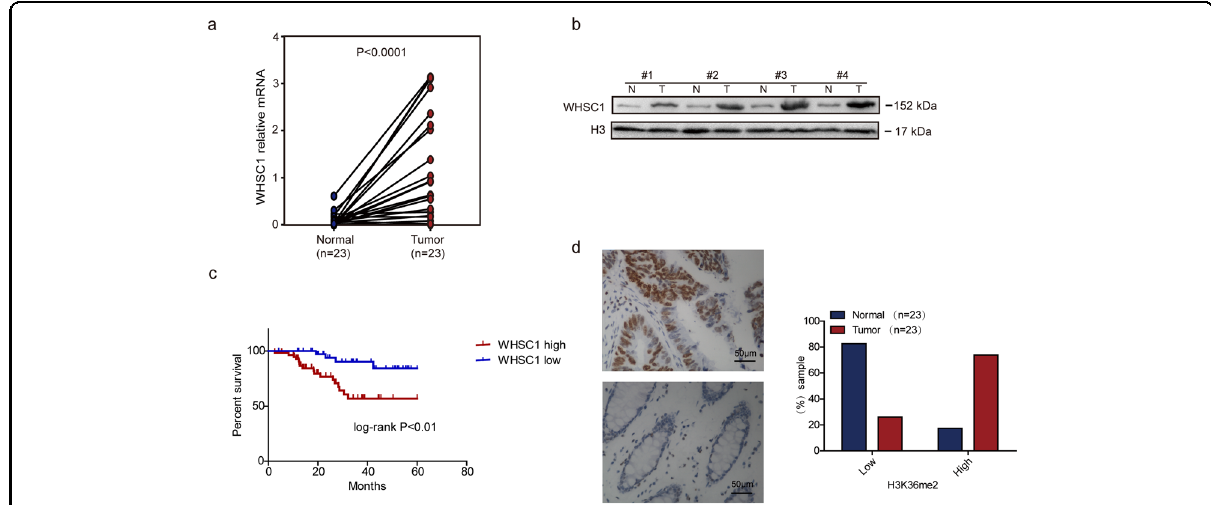
Fig. 1 Elevated WHSC1 expression in human CRC. a WHSC1 mRNA levels in 23 matched tumor and paracarcinoma tissues (paired t- test, P < 0.001). b Immunoblotting analysis of WHSC1 expression in four matched CRC tissues (T) and adjacent noncancerous tissues (N). c Kaplan – Meier plot of overall survival of CRC patients based on WHSC1 levels. A log-rank test was used for statistical analysis. d Expression of H3K36me2 was assessed by immunohistochemistry. H3K36me2 staining indexes using a 10-point quanti fi cation are